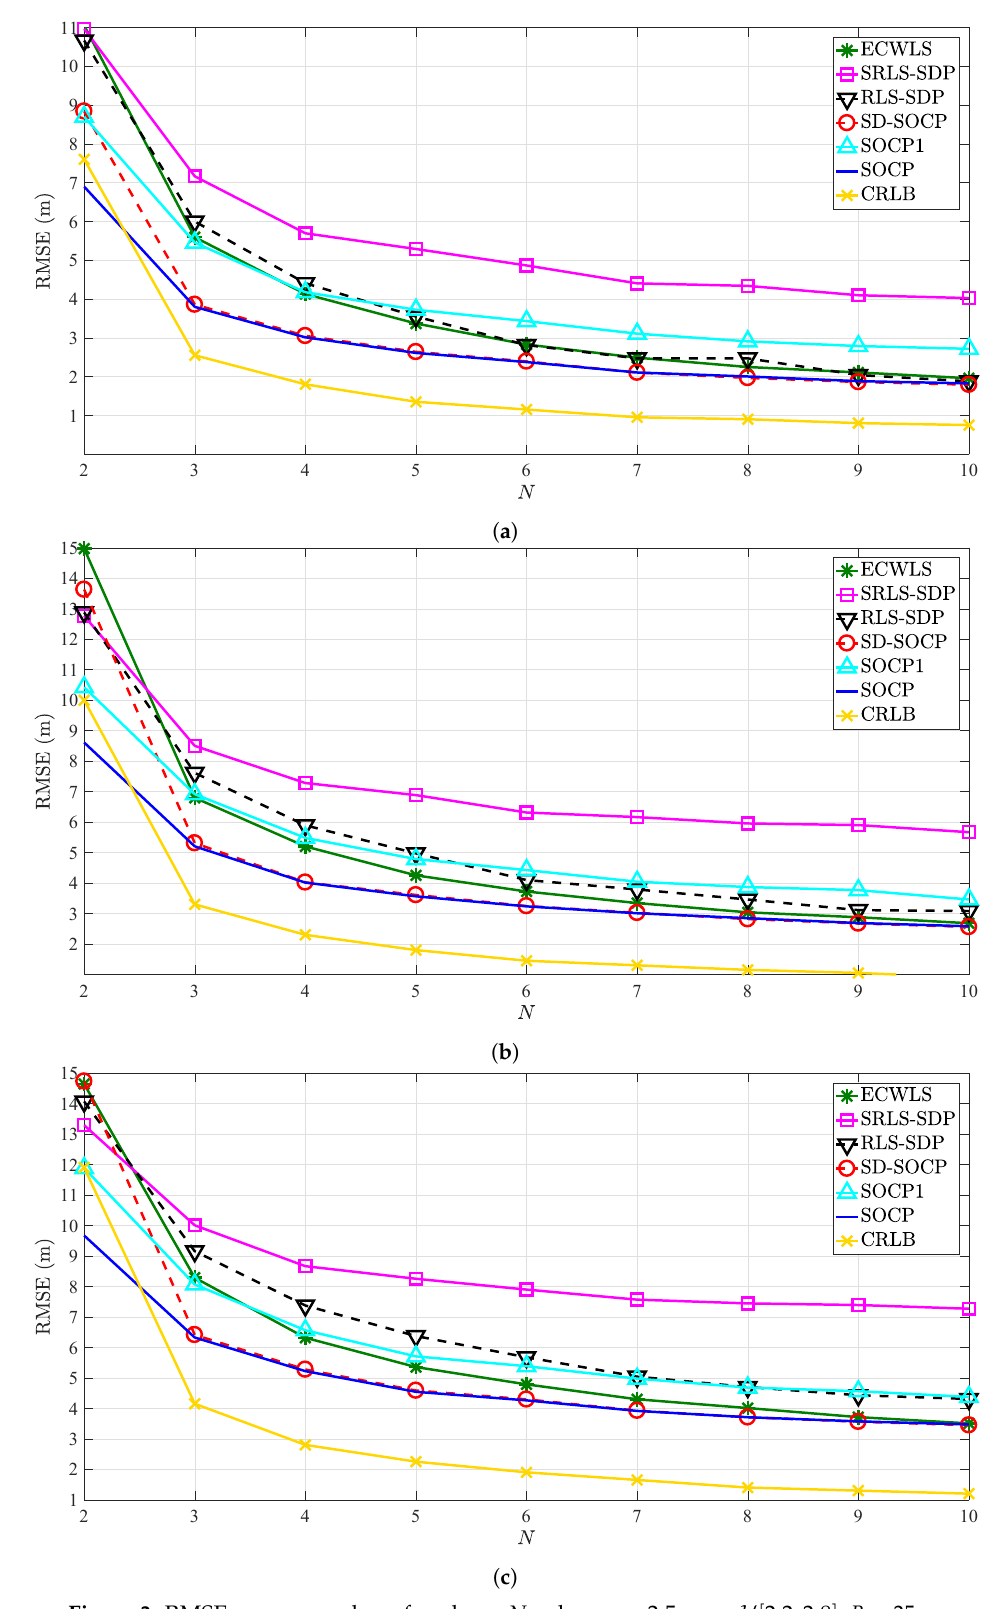
Figure 3. RMSE versus number of anchors, N , when γ = 2.5, γ i ∼ U [ 2.2,2.8 ] , B = 25 m, Mc = 5000. ( a ) σ n κ i = 25.9034 (i.e., σ m